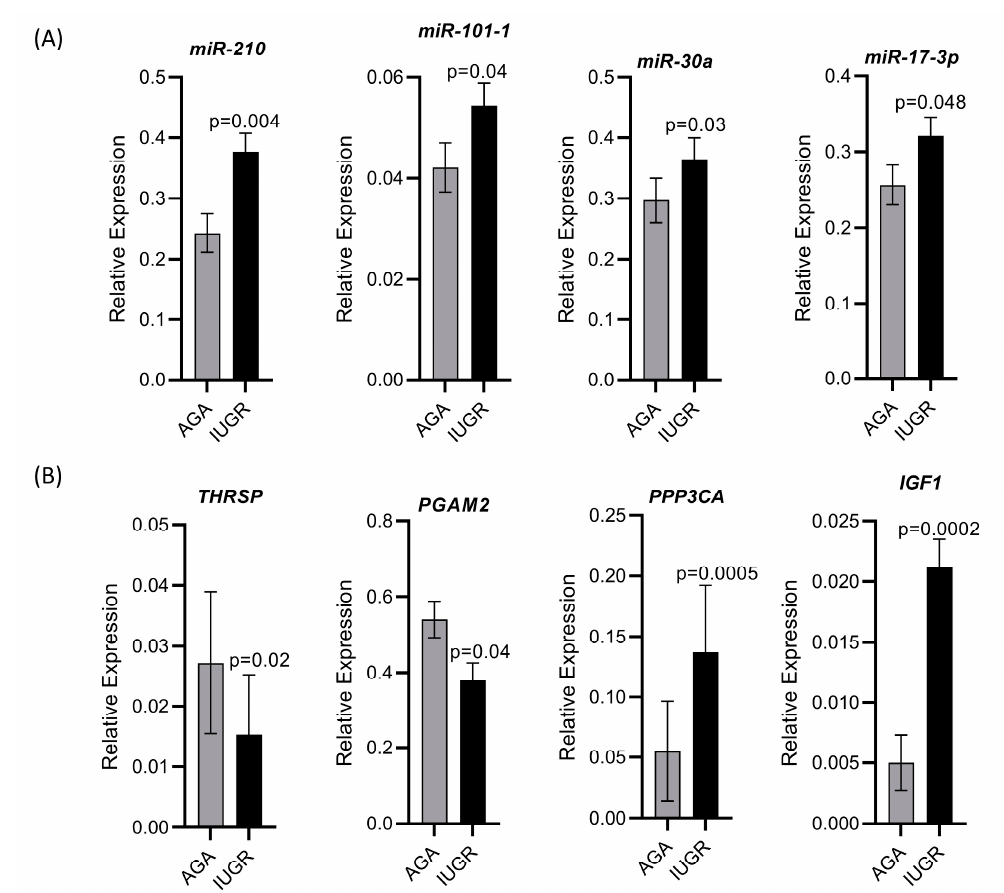
Figure 9. Validation of sequencing data by qPCR for selected miRNAs and mRNAs. ( A ) Relative expression of four upregulated miRNAs quantified through qPCR. ( B ) Relative expression of two downregulated and two upregulated mRNAs quantified through qPCR.